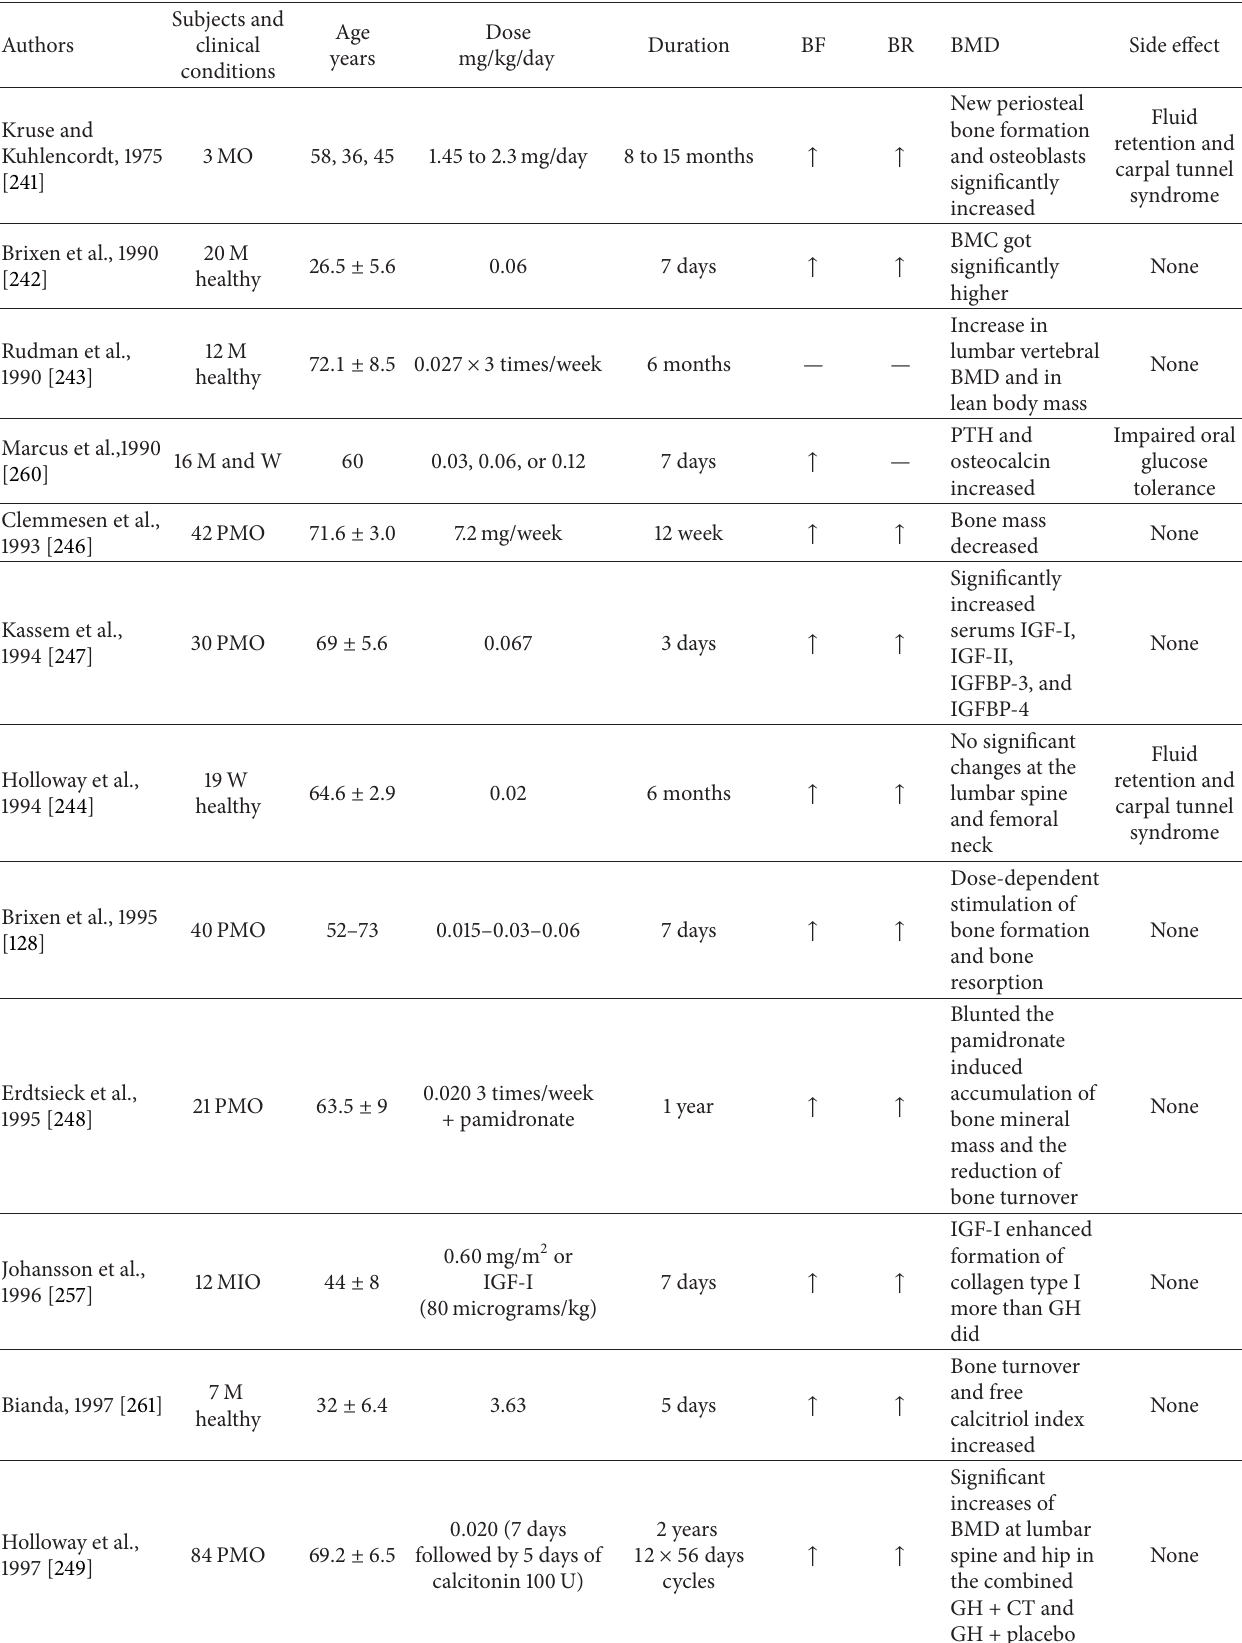
Table 1: Effect of GH administration on osteoporosis and bone